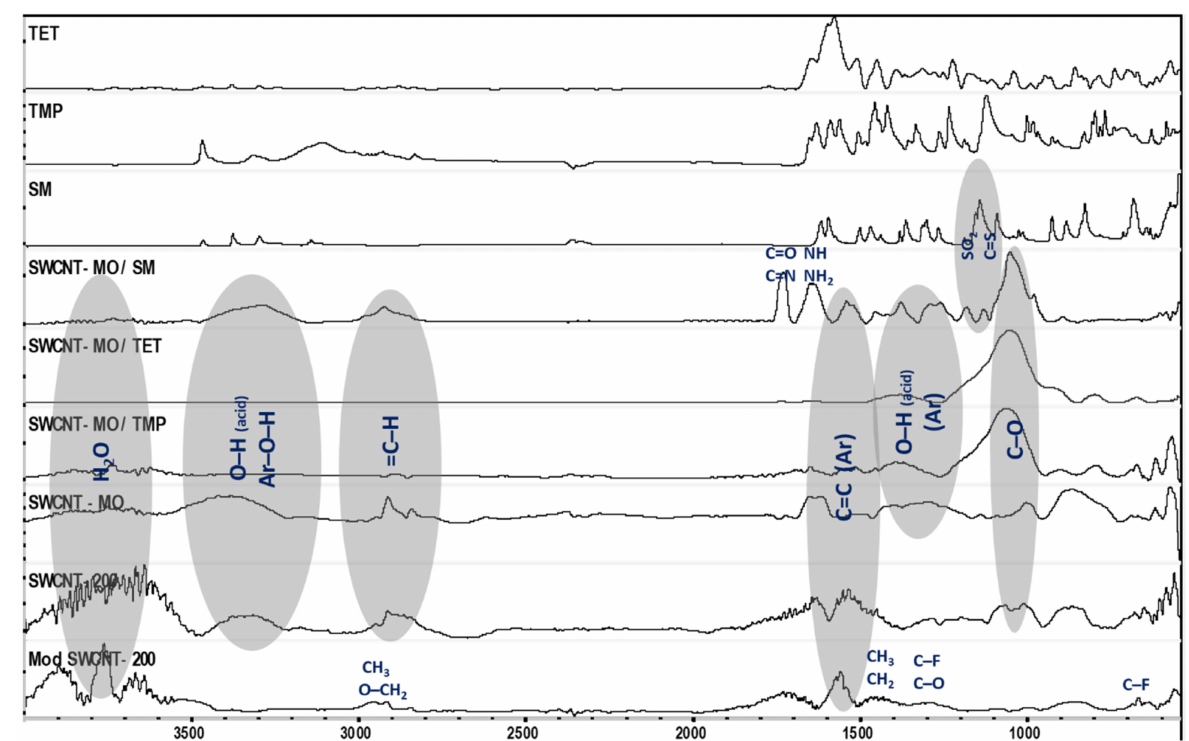
Figure 15. FTIR spectra of TET, TMP, SM, and selected